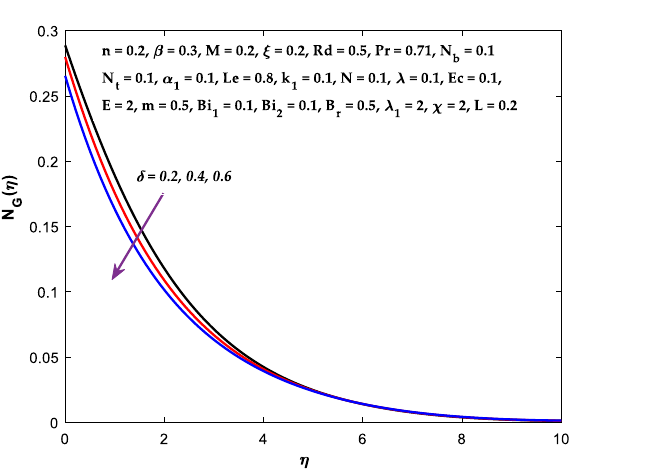
Figure 24. Diagram of δ v/s N G (η)